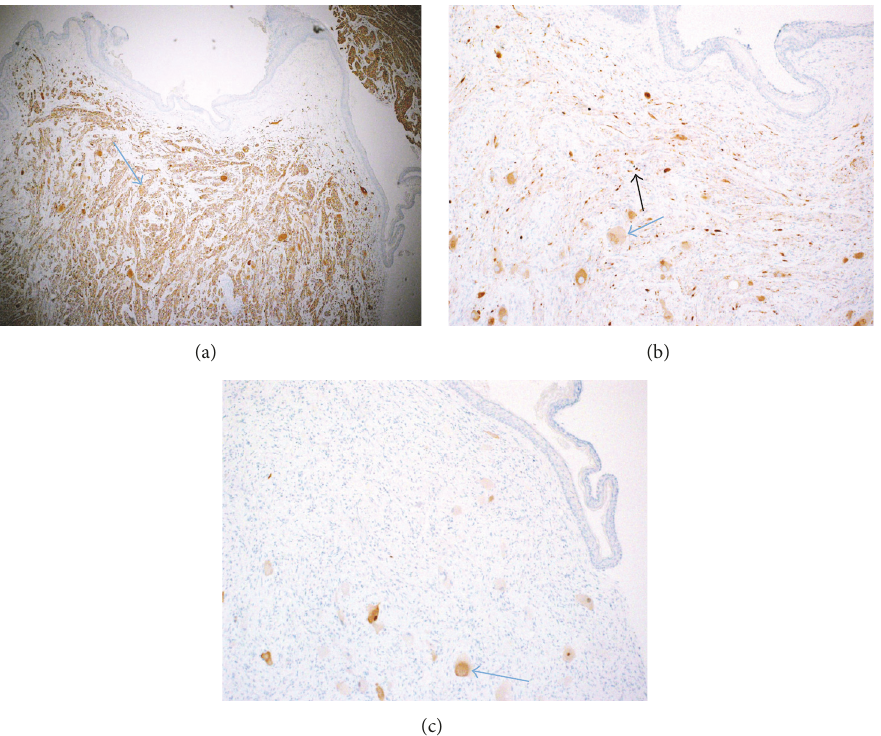
Figure 6: (a) Neurofilaments protein immunostain, showing bundles of axons (arrow). (b) Synaptophysin immunostain, showing cytoplasm of ganglion cells (blue arrow) and also axons (black arrow). (c) Neuronal nuclear immunostain, showing the ganglion cells cytoplasm and nuclei